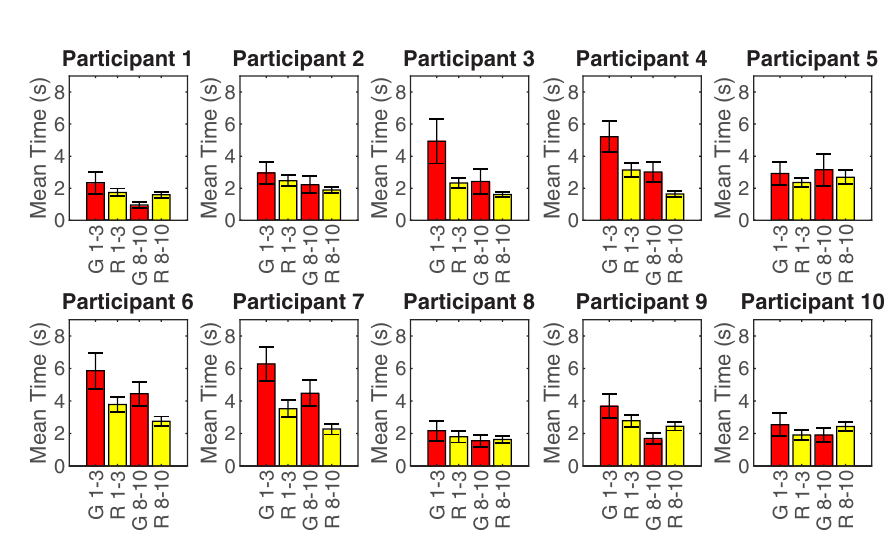
Fig 4. Mean duration of contralateral hand use during grasping/releasing for the first (1–3) and last (8–10) 3 attempts. G 1–3 = Involvement in grasp during attempts 1–3, R 1–3 = Involvement in release during attempts 1–3, G 8–10 = Involvement in grasp during attempts 8–10, R 8–10 = Involvement in release during attempts 8–10. Error bars show the standard